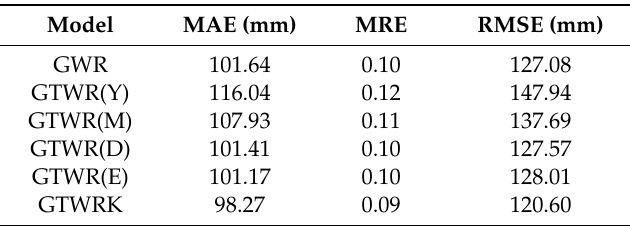
Figure 10. The average error for annual data. Table 3. The average MAE, MRE, and RMSE for the annual data.